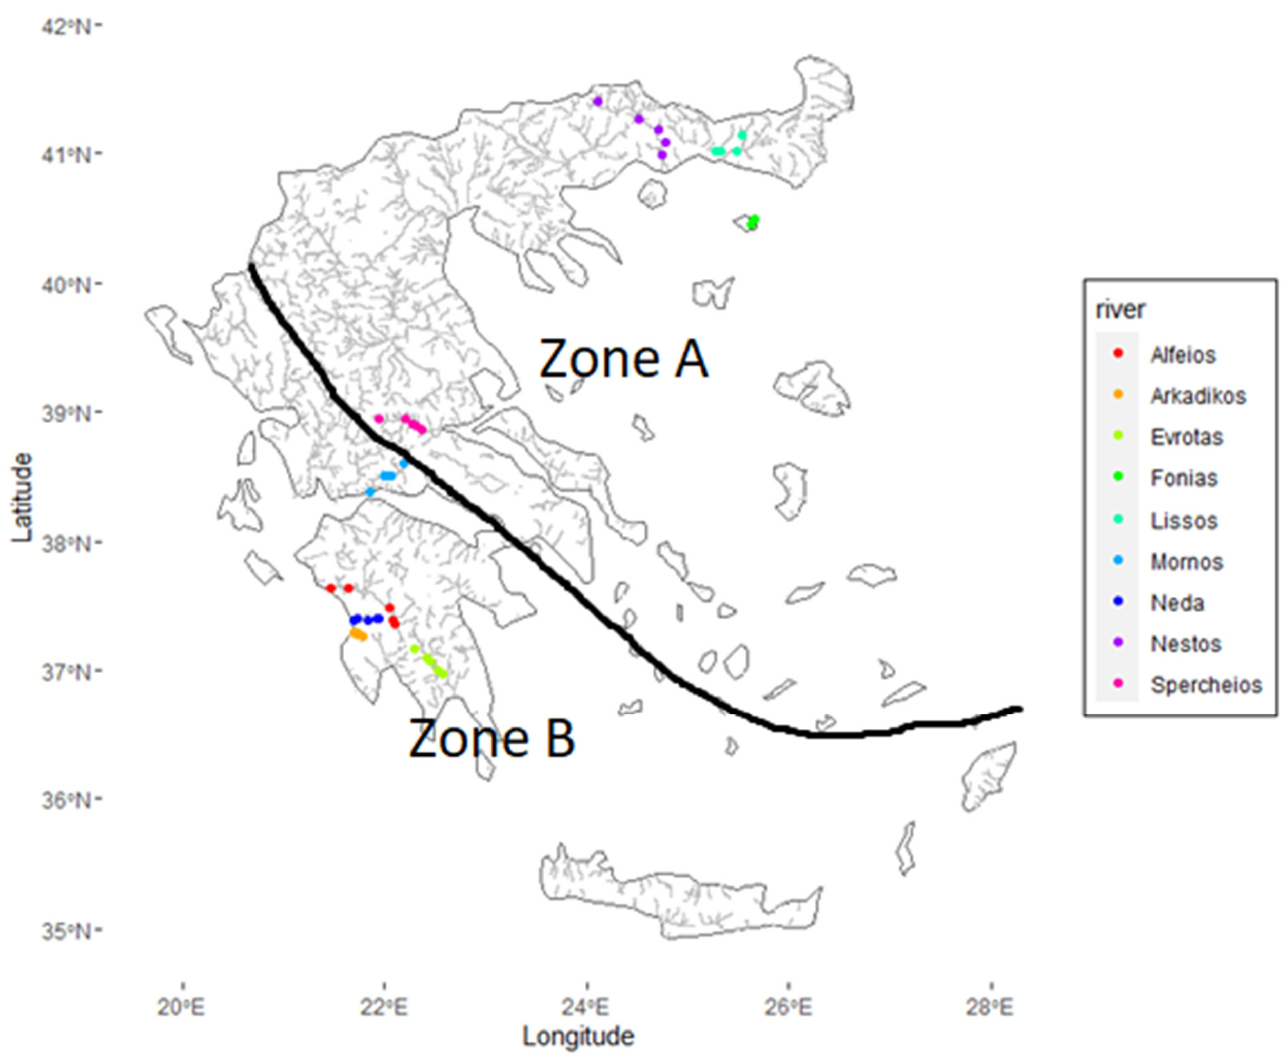
Figure A1. Map with the hydrographic network of Greece and the sampling points for the nine rivers. Hydrographic network is from https://geodata.gov.gr/en/dataset/udrographiko-diktuo (accessed on 6 December 2022). Map was created in R (v. 4.0.3), using packages rnaturalearth (v. 0.1.0), sf (v. 1.0-6) and ggplot2 (v. 3.5.3).